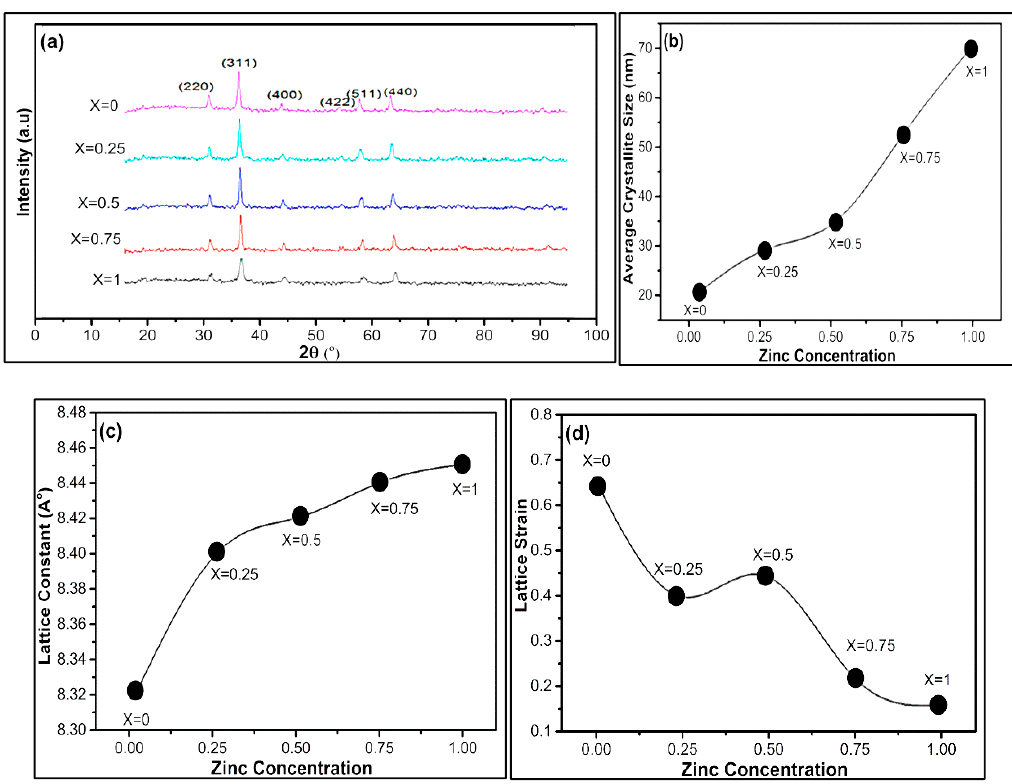
Figure 2. ( a ) The X-Ray diffraction pattern for Ni 1-x Zn x Fe 2 O 4 nanoferrites (x = 0, 0.25, 0.5, 0.75, 1). The influence of Zn doping on average ( b ) crystallite size, ( c ) lattice constant, and ( d ) lattice strain. Table 1. Crystallite size, lattice constant, and lattice strain for Ni 1-x Zn x Fe 2 O 4 .